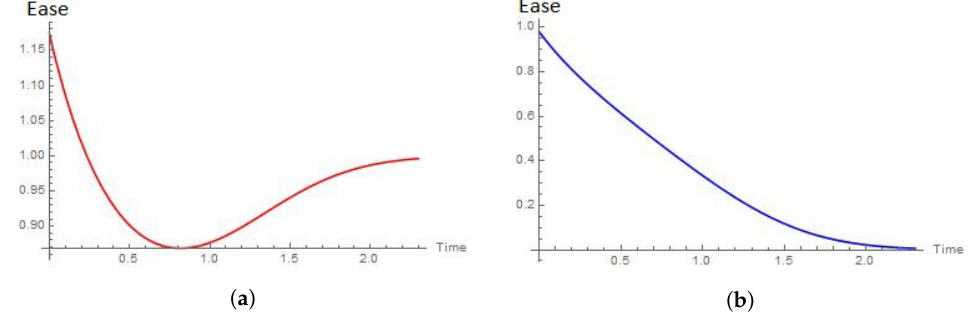
Figure 18. Ease of the efforts when the shape parameters of Weibull and Chen distributions are δ 1 = 2 and δ 2 = 2, respectively. ( a ) Ease of the effort required by Weibull extractor when δ 1 = 2. ( b ) Ease of the effort required by Chen extractor when δ 2 =